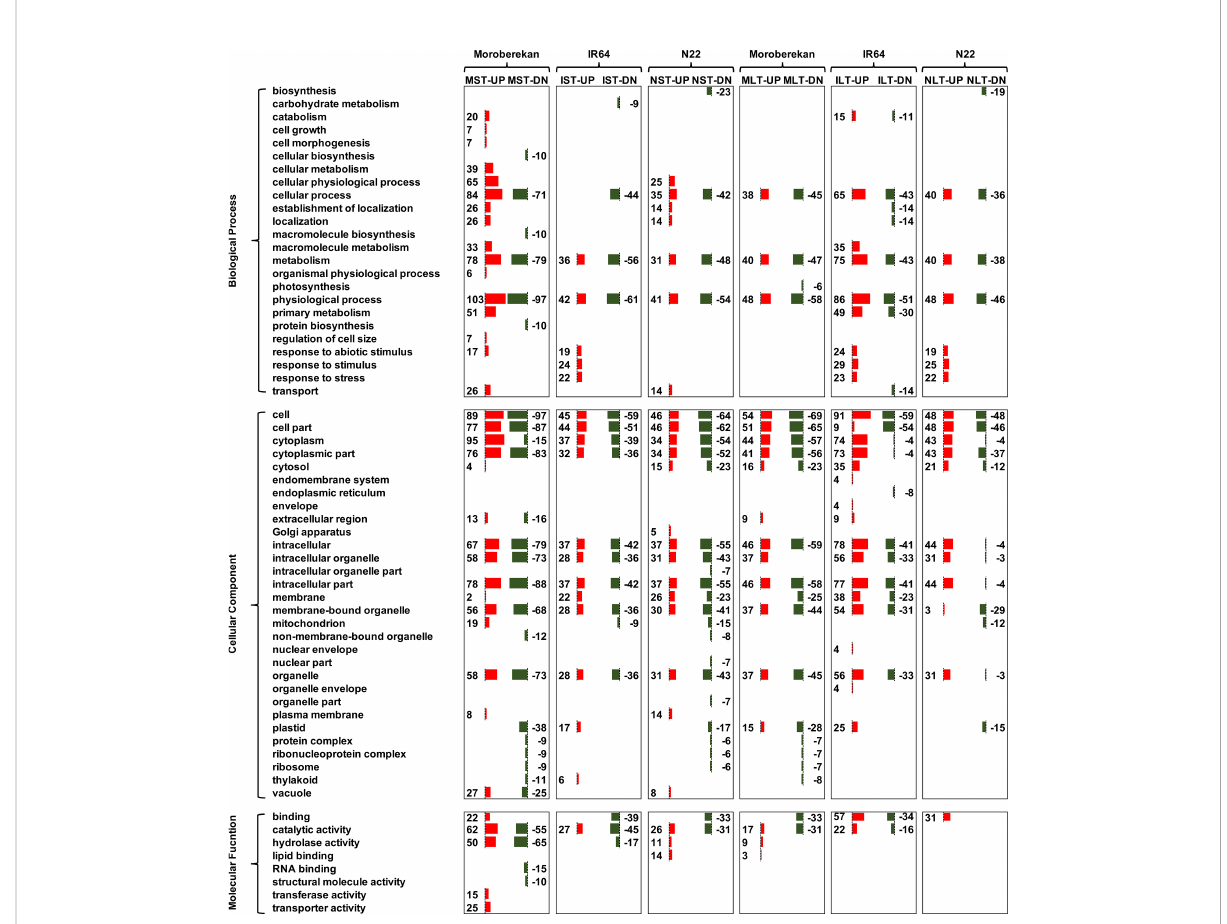
FIGURE 5 GO term enrichment analysis using RiceNetDB for the proteins up- and down regulated in short-term (ST) and long-term (LT) heat stress conditions in Moroberekan, IR64 and N22 rice genotypes. The numbers are indicative of the proteins enriched for each GO